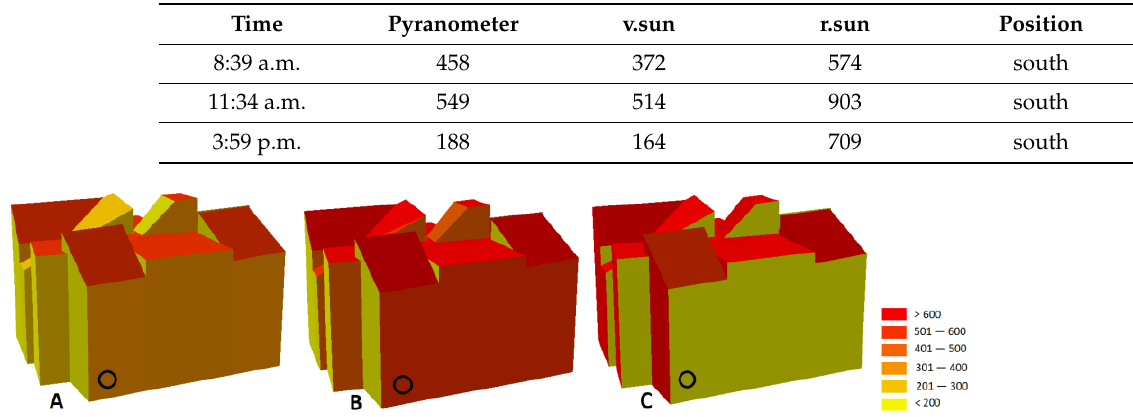
Table 2. Solar irradiance at the residential house in Muránska street in W/m 2 on 23 June 2021. Time